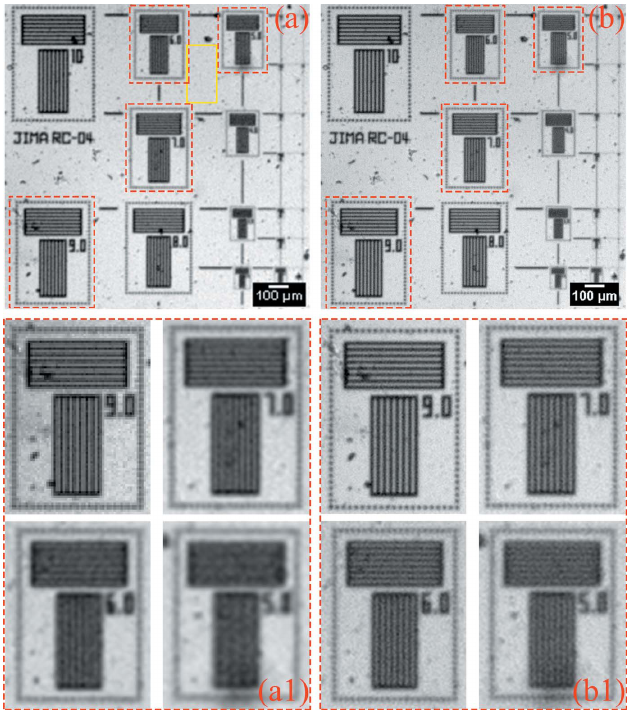
Figure 14 The 3 (cid:2) 3 mode experimental results of using visible light. ( a ) The projection (pixel size: 6.5 m m (cid:2) 6.5 m m; pixel number: 230 (cid:2) 230). ( b ) The oversampled image with deconvolution (pixel size: 2.17 m m (cid:2) 2.17 m m; pixel number: 690 (cid:2) 690). Panels ( a ) and ( b ) are only part of the image to show the details more clearly. Panels ( a 1) and ( b 1) correspond to the magnified images in the red boxes of ( a ) and ( b ), respectively.